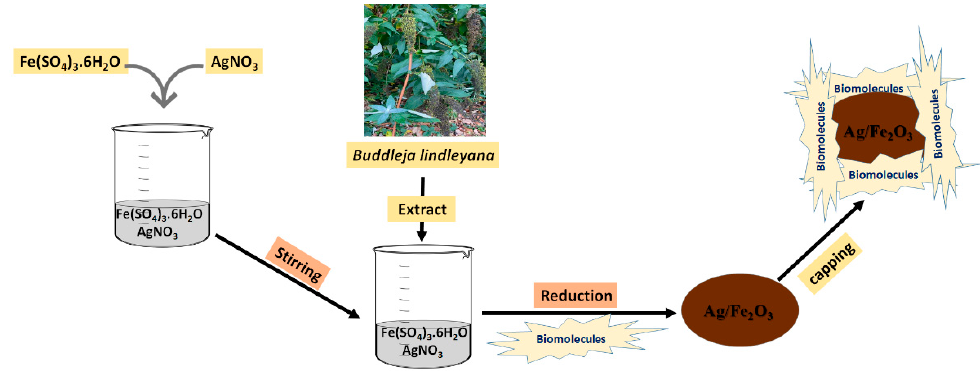
Figure 1. The mechanism of the reduction process of the Ag/Fe 2 O 3 nanocomposite using Buddleja lindleyana extract.